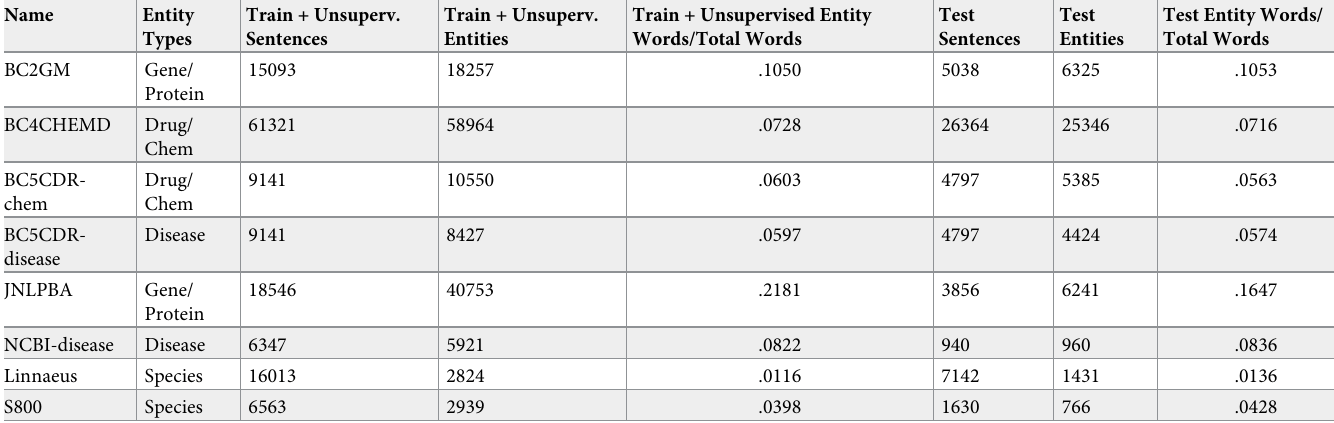
Table 2. Detailed information about each of our NER